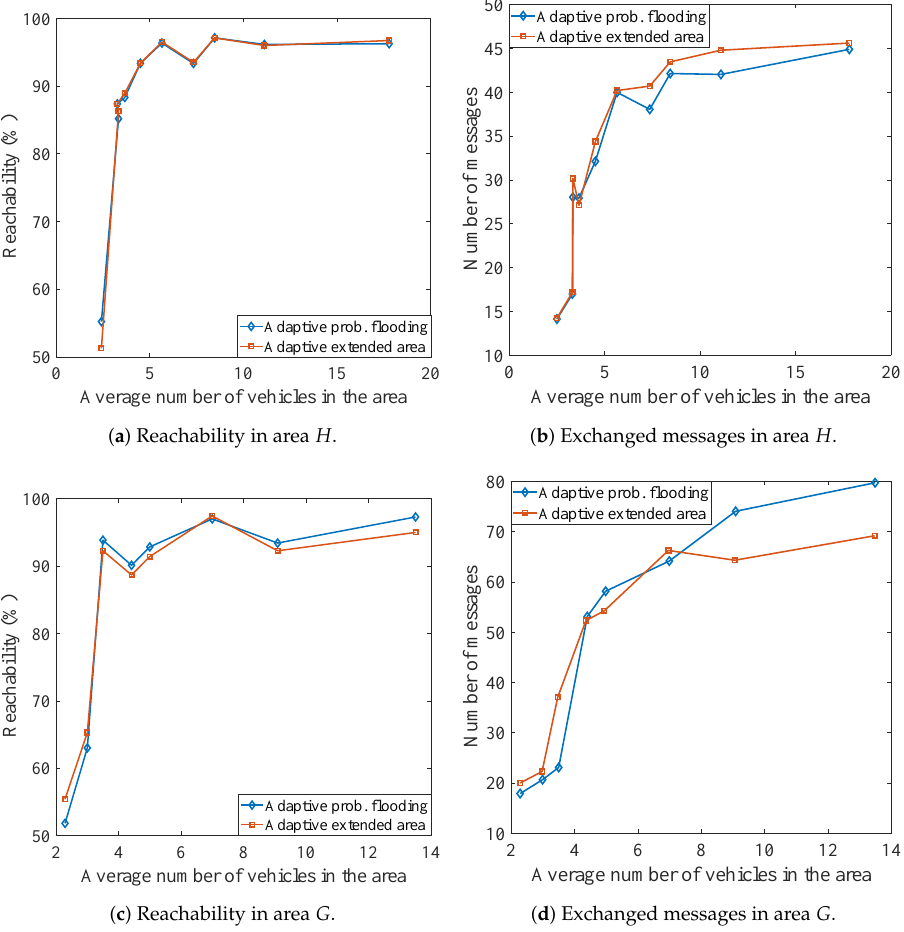
Figure 14. Comparison of the adaptive probabilistic flooding hovering scheme with the adaptive version of the hovering protocol proposed in Reference [28] in terms of the reachability achieved and the number of exchanged messages in areas H and G for different average number of vehicles in the